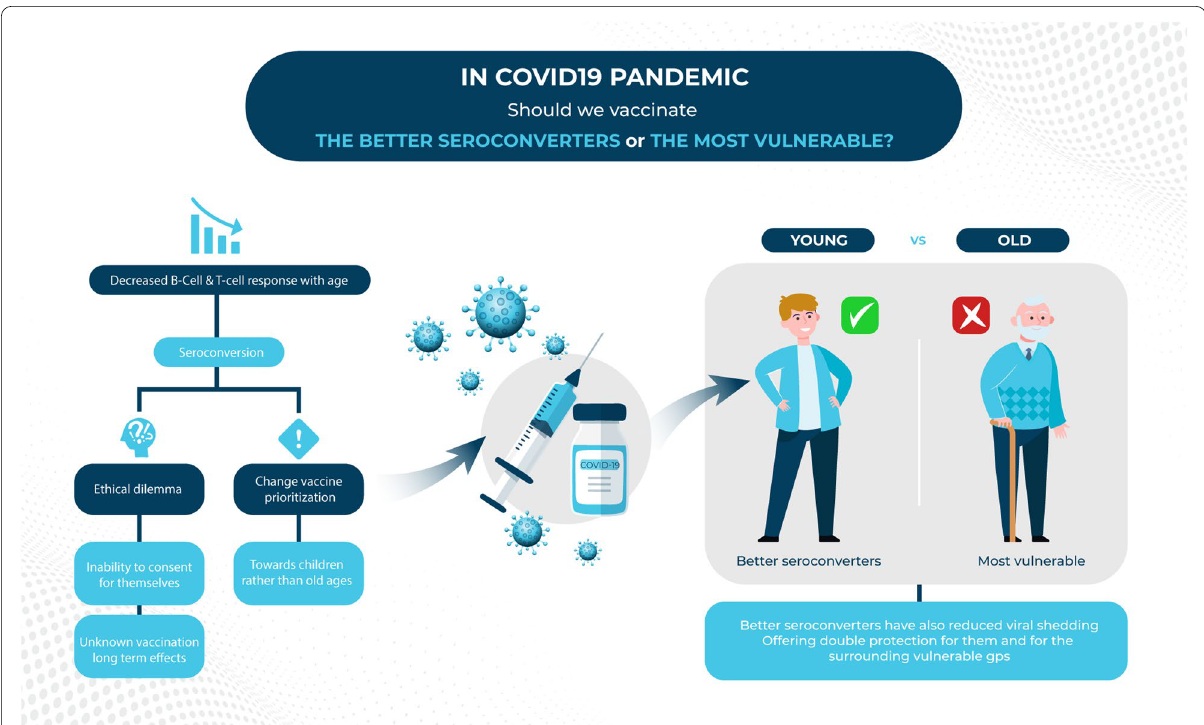
Fig. 1 In COVID19 pandemic, should we vaccinate the better seroconverters or the most vulnerable? COVID19 coronavirus disease